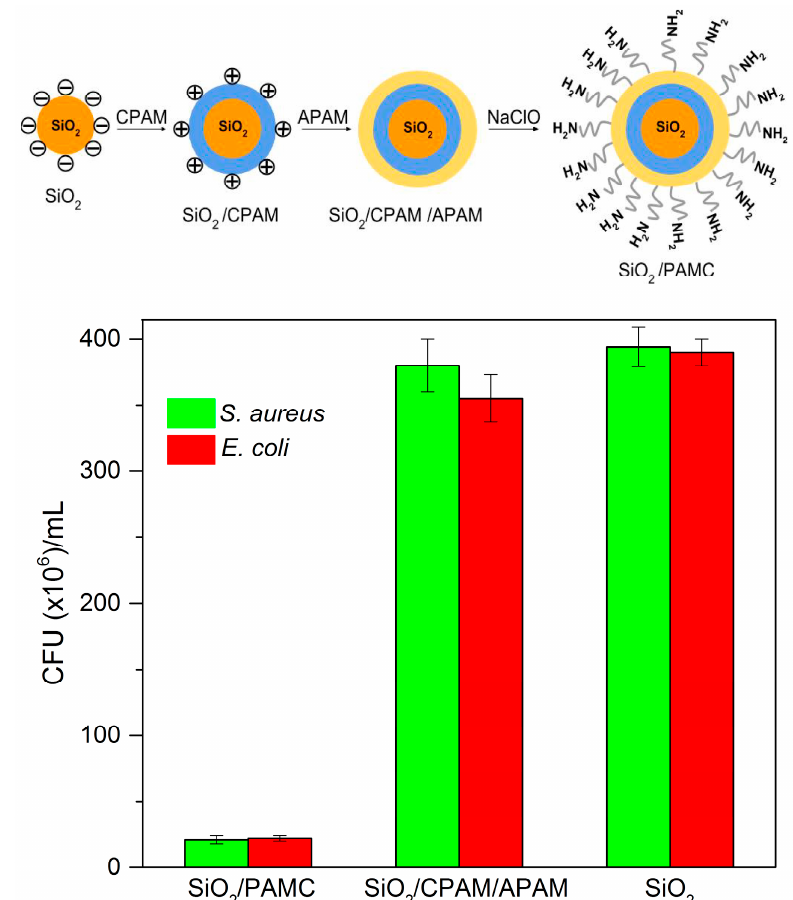
Figure 7. The microbicidal activity of cationic SiO 2 /anionic polyacrylamide (APAM) bleached nanoparticles (PAMC) from colony forming unities counting on agar plates. Adapted from [138] with permission from the Royal Society of Chemistry. CPAM: cationic polyacrylamide.